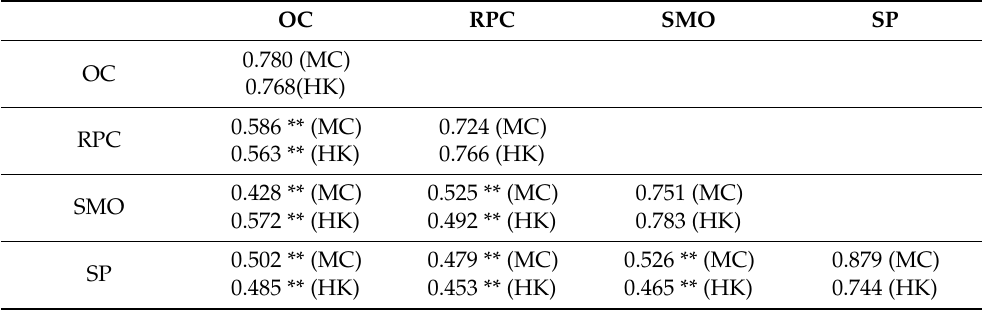
Table 5. Confirmatory correlations of inter-factor among latent variables for Mainland China